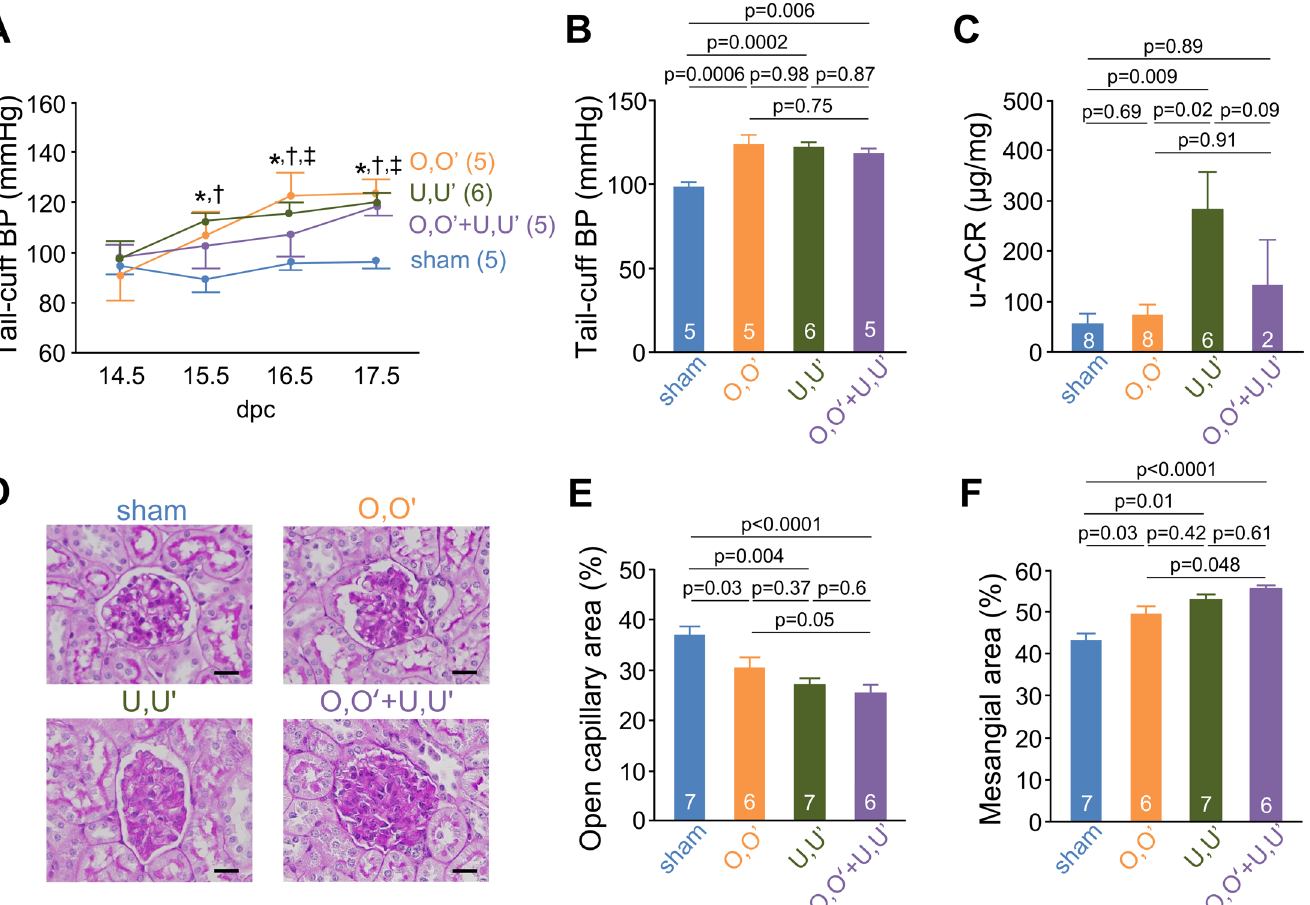
Fig 3. RUPP causes hypertension, proteinuria, and glomerular endotheliosis. ( A ) Tail-cuff blood pressure. * p < 0.05 between sham and O,O ’ ; † p < 0.05 between sham and U,U ’ ; ‡ p < 0.05 between sham and O,O ’ +U,U ’ . ( B ) Tail-cuff blood pressure at 17.5 dpc, 1 day before animals were killed. ( C ) Albumin/creatinine ratio (ACR) of urine samples at 18.5 dpc. ( D ) Representative glomeruli from sham, O,O ’ , U,U ’ , and O,O ’ +U,U ’ . Periodic acid – Schiff stain. Bars, 20 μ m. ( E ), ( F ) Quantitative estimates of glomerular open capillary area (index of endotheliosis) ( E ) and PAS-positive area (mesangium) ( F ) in the kidneys of 18.5 dpc pregnant mice normalized to glomerular tuft